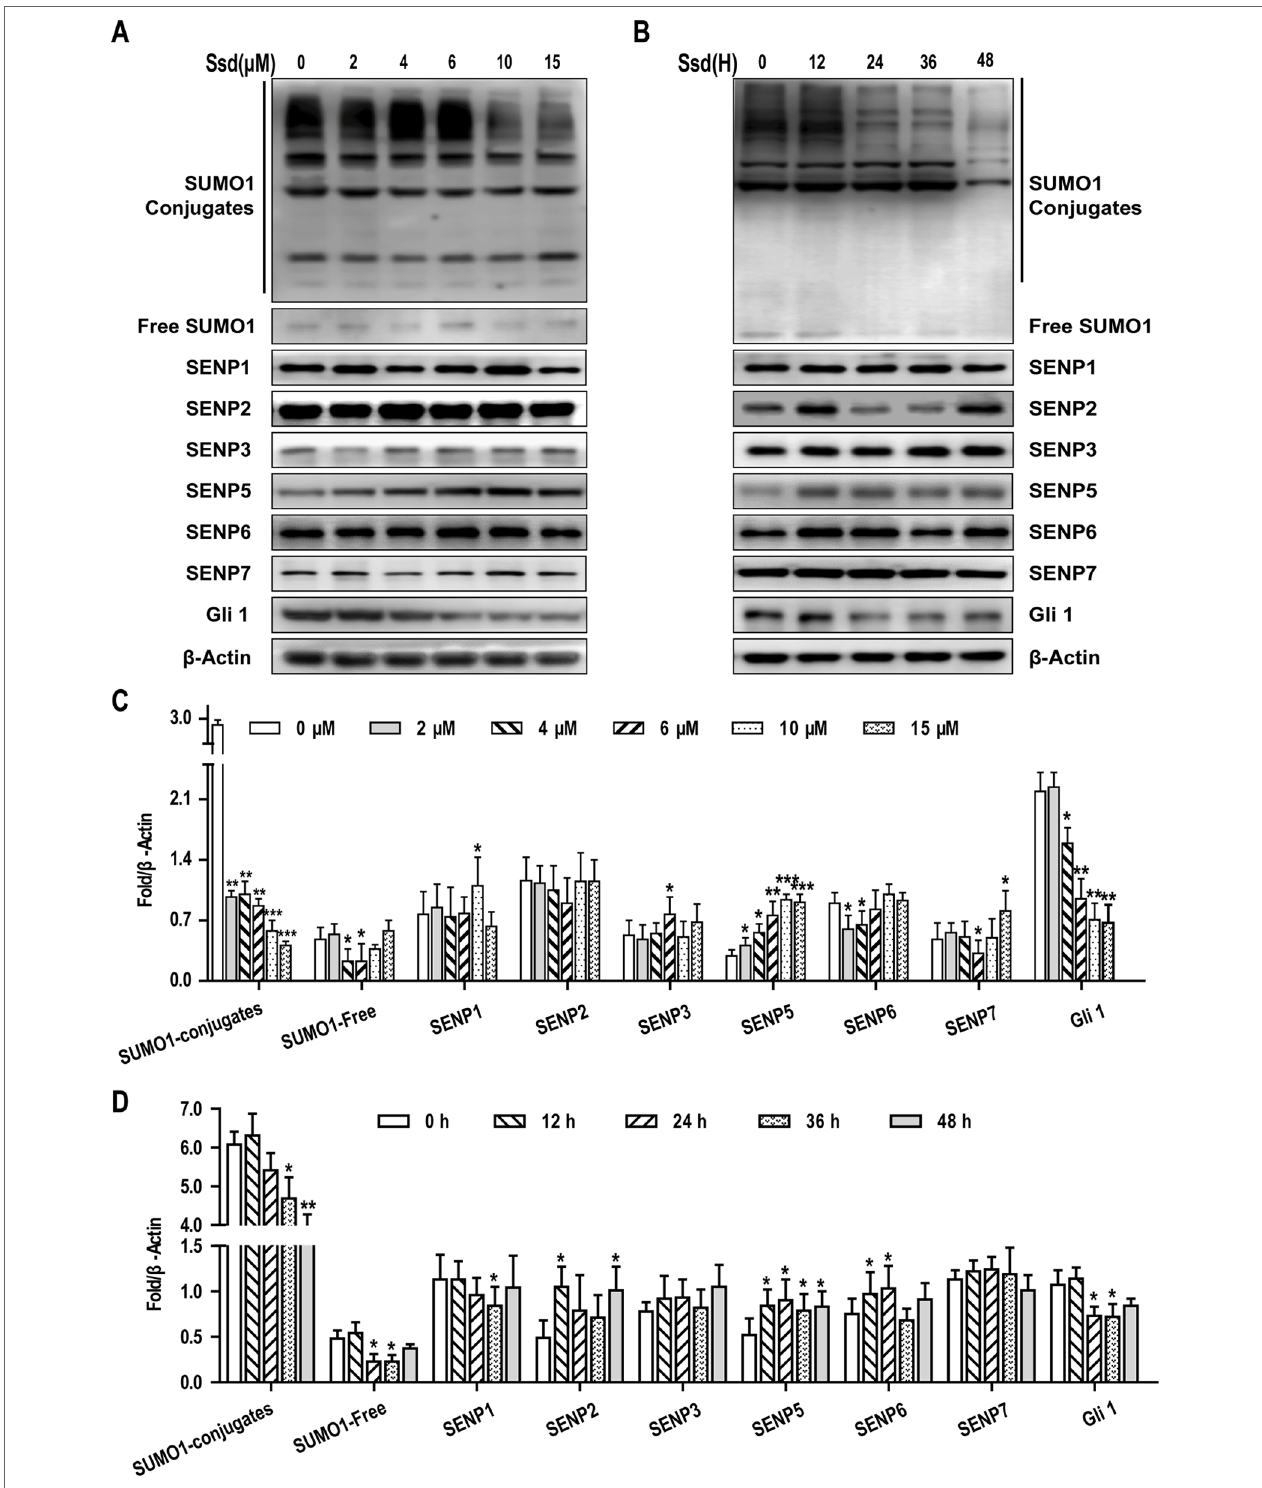
FIGURE 5 | Saikosaponin-d (Ssd) may inhibit the SUMOylation of Gli1 by specifically upregulating the expression of SENP5. (A) Concentration-dependent effects of Ssd treatment on SUMO1, SENP1–3, SENP5–7, and Gli1 protein expression in Hep3B cells, as determined by western blotting. Cells were treated with the indicated concentrations of Ssd for 48 h. (B) Time-dependent effects of Ssd treatment (6 µM) on the same proteins examined in (A) . (C , D) Quantitative analysis of western blotting data presented in (A and B) . Protein expression data are normalized to the β -actin control and are expressed as means ± SD (n = 3); * P < 0.05 and ** P < 0.01 when compared with control (Student’s t